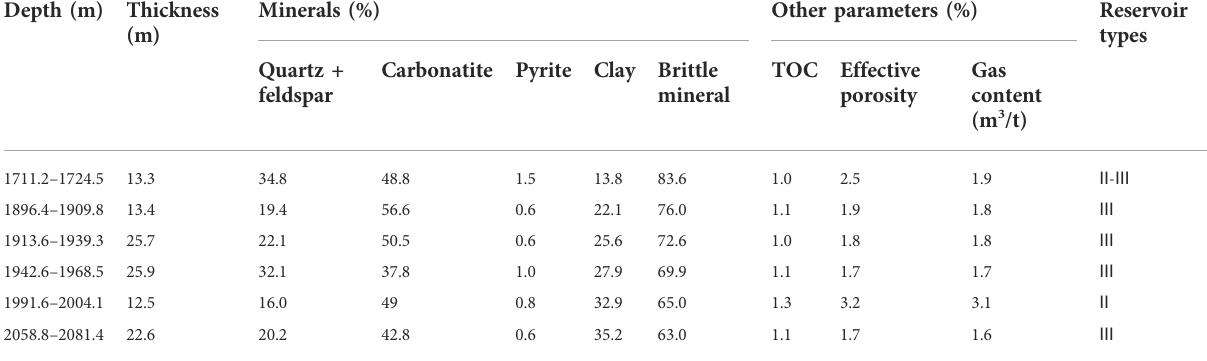
TABLE 6 Evaluation of the YS302 with new standards.